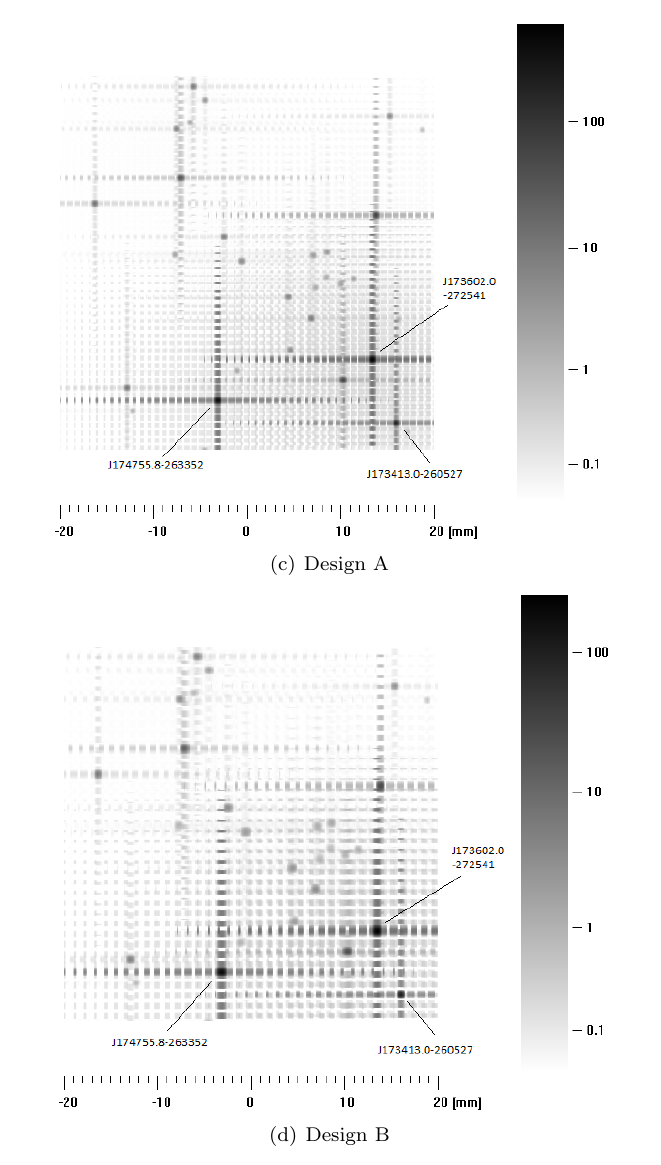
Fig. 7. Simulation of imaging of the Galactic center. The coordinates of the area center are (cid:11) = 17:45:40, (cid:14) = –29:00:28. The imaged area corresponds to the supposed field of view 7 : 2 ◦ (cid:2) 7 : 9 ◦ . The horizontal axis is aligned with right ascension and the vertical axis with declination. The dimension is scaled is millimeters in the focal plane. The levels of gray correspond to the measured flux. The scale at the right-hand side is in number of photons per second per cm 2 in the corresponding point of the